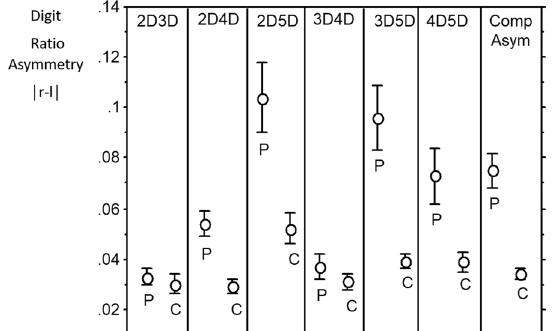
Figure 1. Means (SE error bars) patient (P) and control (C) unsigned asymmetries (|right–left)|) for the digit ratios of 2D:3D; 2D:4D; 2D:5D; 3D:4D; 3D:5D and 4D:5D. Clinical composite asymmetry (Comp Asym) is (|right–left)|2D:4D + |right–left)| 3D:5D)/2.